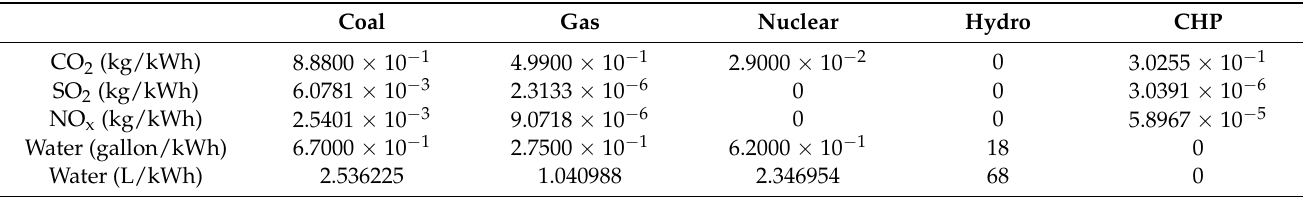
Table A2. Generation type emission levels